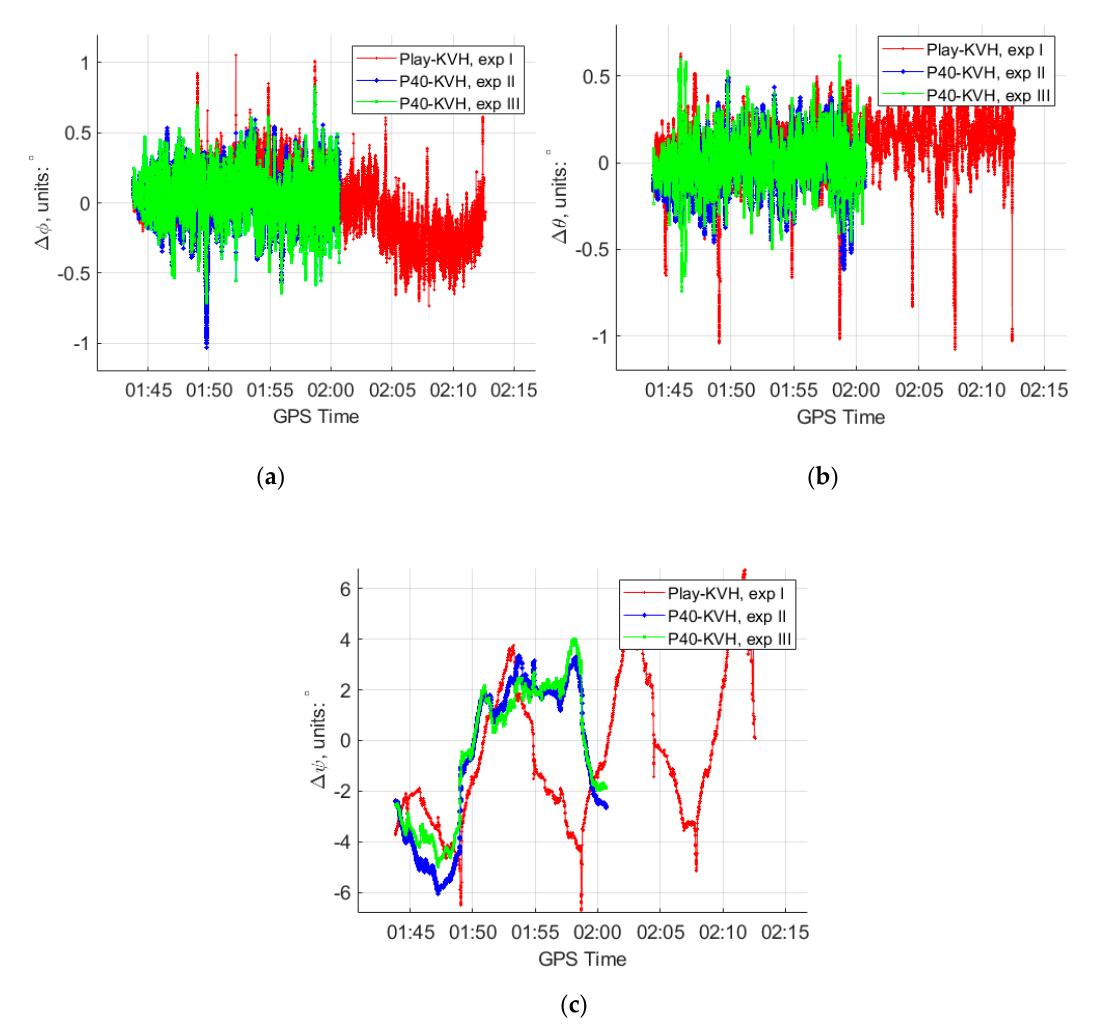
Figure 7. The attitude differences of the GNSS/IMU coupled solutions between the two smartphones (our program in a 15-state Kalman filter) and the ‘‘KVH 1750” (IE software) in GNSS open-sky condition at experiment I, II and III. ( a ) Roll differences; ( b ) pitch differences; ( c ) yaw differences. The RMS (root mean square) statistics of the comparison differences between the position, velocity and attitude solutions of the three experiments are shown in Table 2. Table 2. The root mean square (RMS) statistics of the differences of the GNSS/IMU coupled solutions between the two smartphones (our program in a 15-state Kalman filter) and the ‘‘KVH 1750” (IE software).